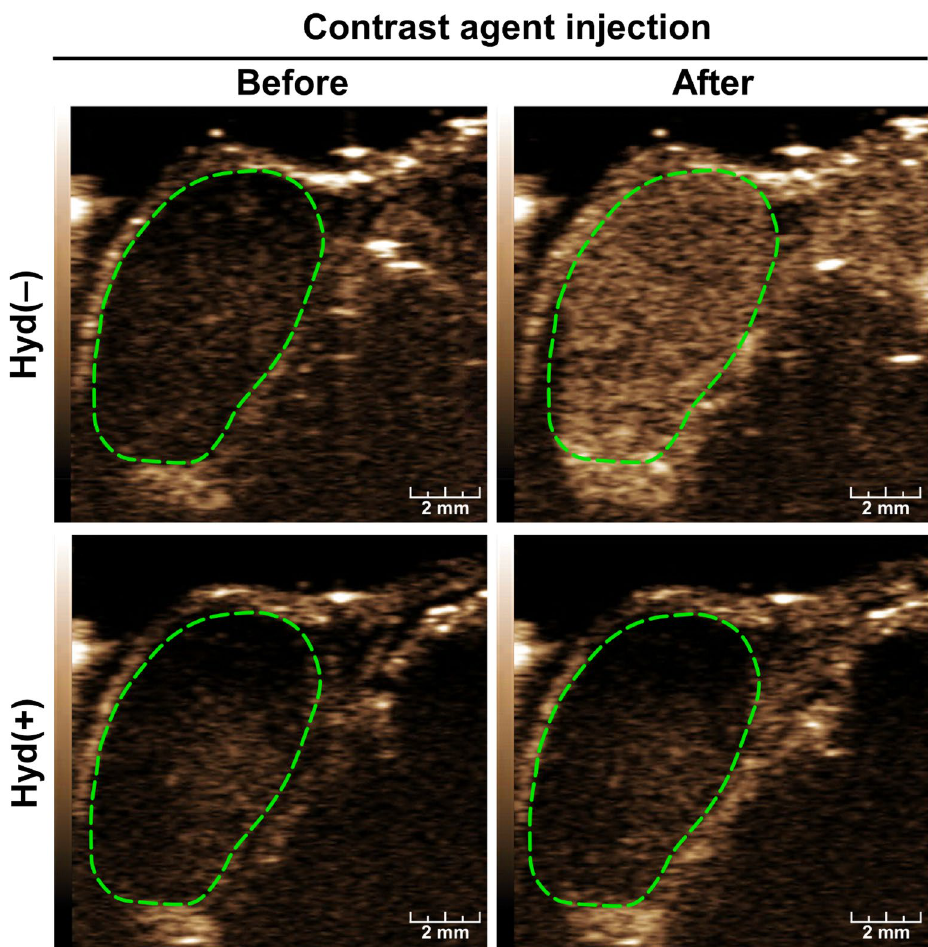
Figure 1. Effects of hydralazine alone on HCC blood flow. Non-linear contrast-enhanced (NLC) images of the tumor were acquired before (left panel) and after (right panel) intravenous injections of the contrast agent with [Hyd(+)] or without [Hyd(−)] administration of 5 mg/kg hydralazine; the margins of the tumor defined by the green dotted lines were outlined on the grayscale images (not shown) and copied to the NLC image acquired simultaneously. The CEUS images demonstrated that before hydralazine administration the tumor and the surrounding tissues were highly vascular, represented by the inflow of contrast agent (panels in the top row). The inflow of contrast agent through the tumor was substantially reduced following hydralazine treatment (panels in the bottom row). Scale bar = 2